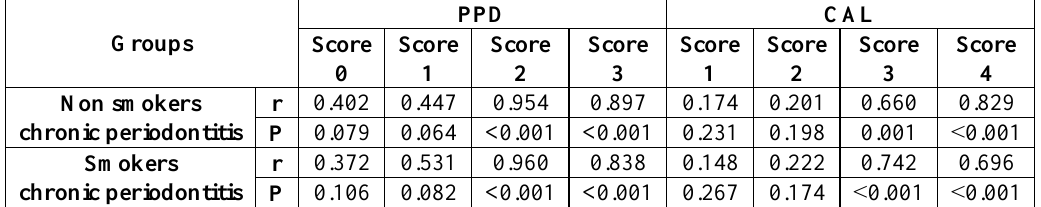
Table 6: correlations of (PPD and CAL) scores and MMP-9 levels in smokers and non